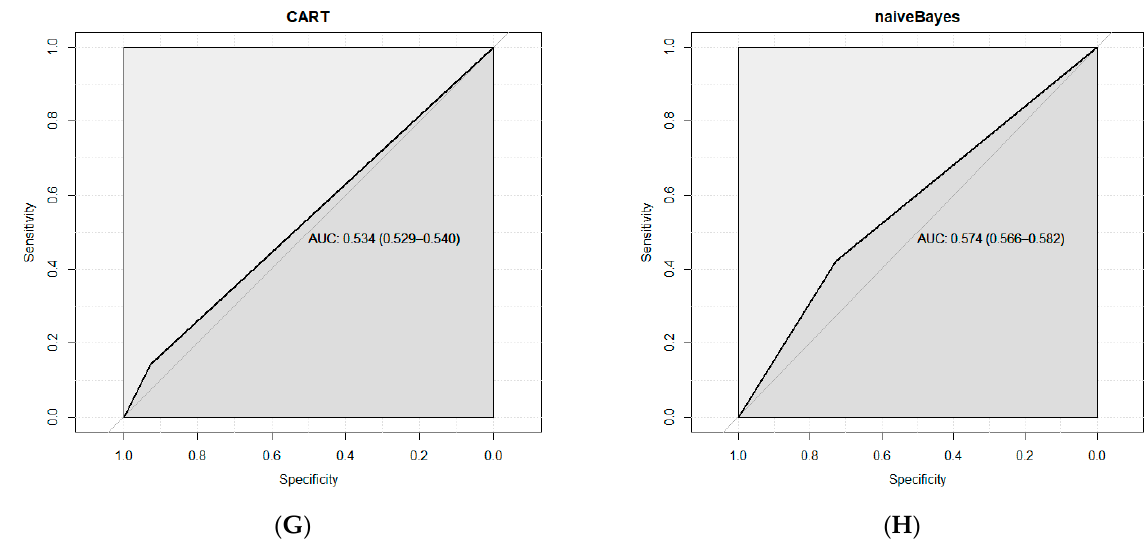
Figure 12. ROC and calculated AUC obtained for the classifier models of ( A ) RF, ( B ) C50, ( C ) XGBoost, ( D ) J48, ( E ) K-NN, ( F ) LR, ( G ) caret, and ( H ) naïve Bayes.